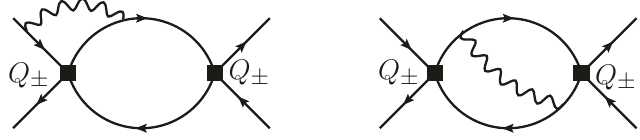
Figure 1 . Sample Feynman diagrams with bilocal insertions of the current-current operators Q qq 0 Solid lines denote appropriate quark flavors, and wavy lines denote